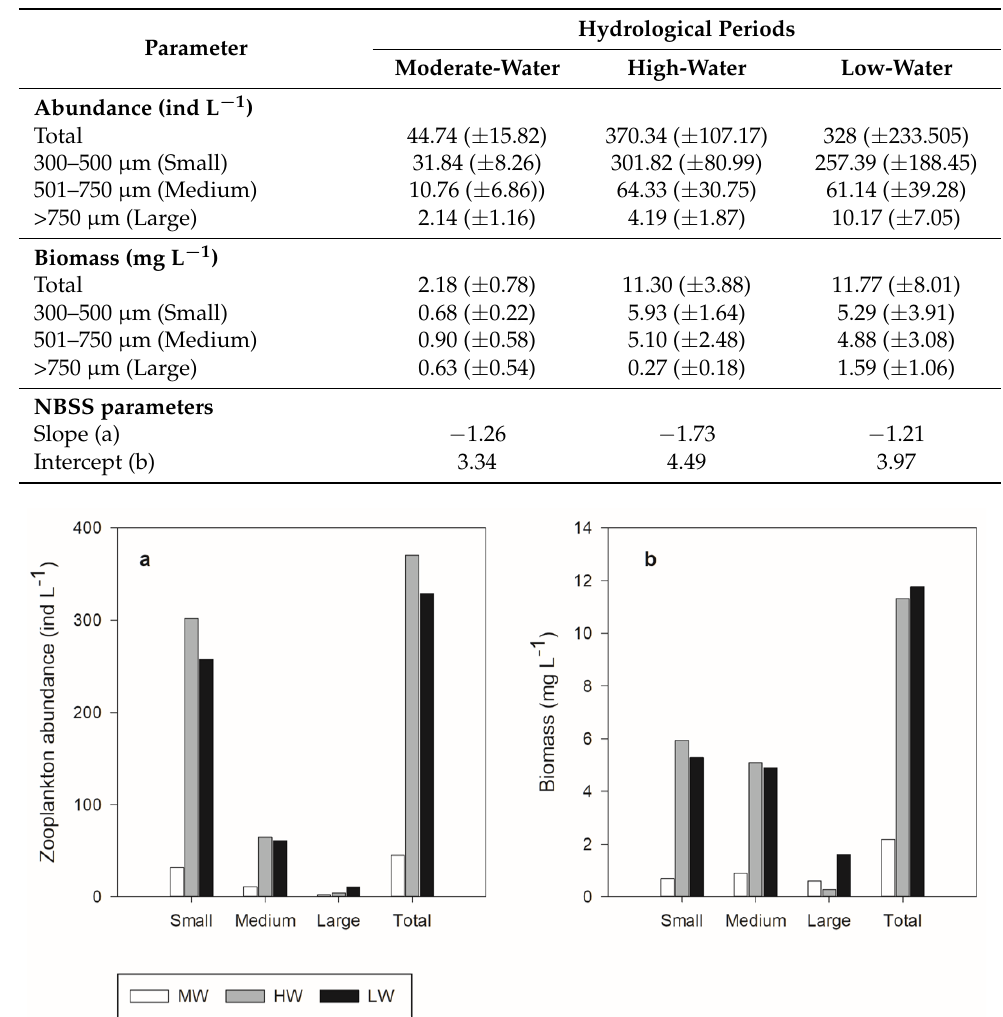
Table 4. Summary of zooplankton average abundance ( ± standard deviation) and biomass of each size class during the three hydrological periods in Lake Tempe.